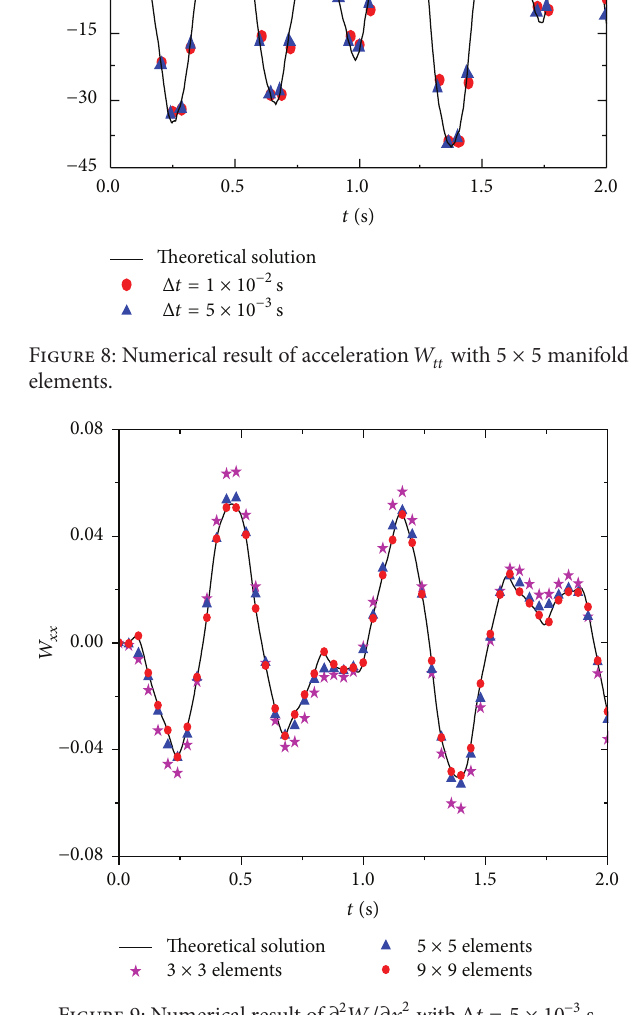
Figure 7: Numerical result of velocity 𝑊 𝑡 with 5 × 5 manifold elements.